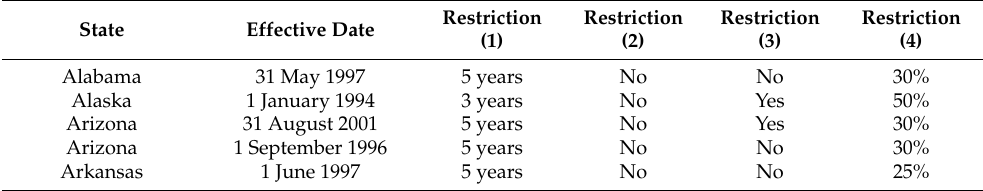
Table A1. State Interstate Bank Branching Laws: